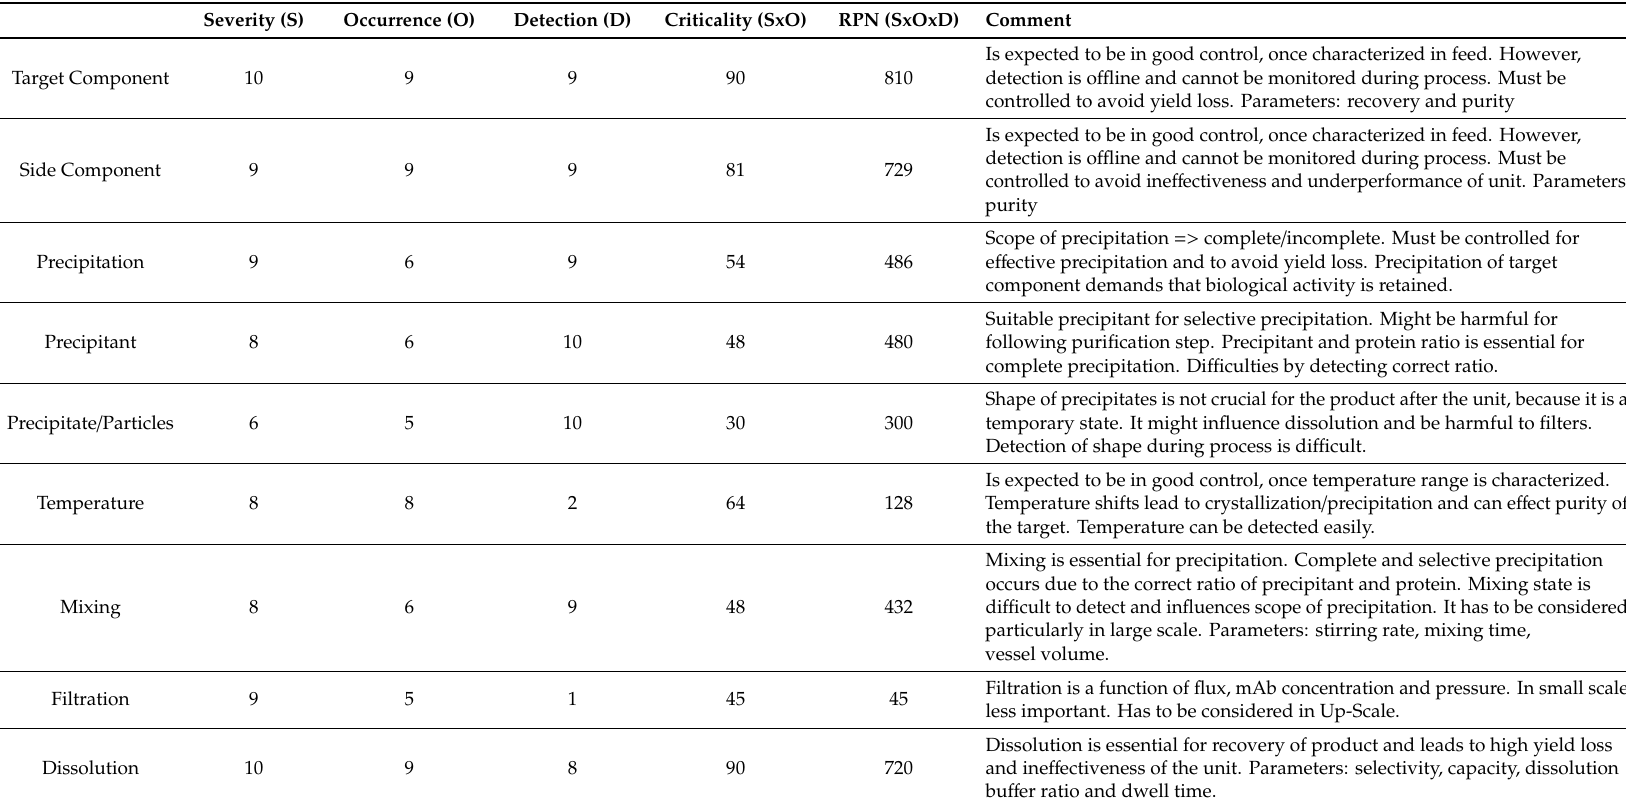
Table A1. Risk Assessment: Failure- mode-e ff ect-analysis (FMEA). Foundation for conducted